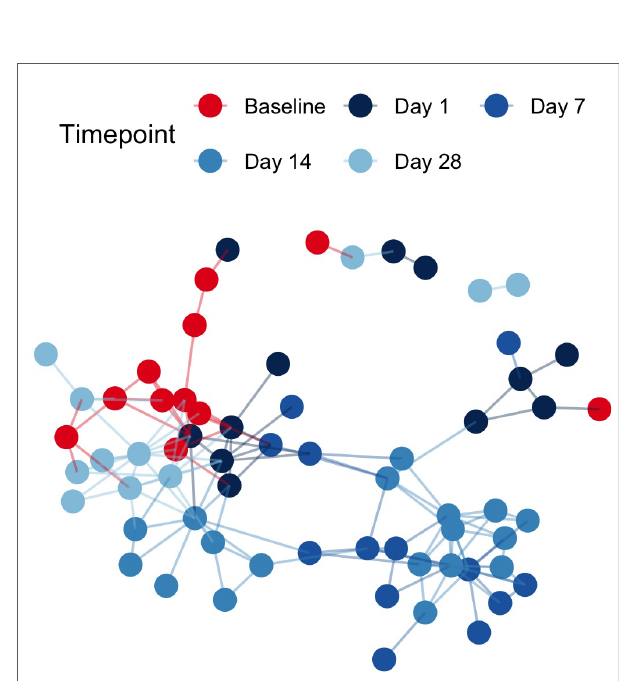
FIGURE 2 Sample networks of surface swabs connect samples with similar microbial community compositions (weighted jaccard distance<0.4) when colored by pre/post AIONX ® intervention and sampling day reveal successional changes in the microbial community over time. A total of 26 isolated vertices represented samples with<60% taxa in common with any other samples have been omitted from the